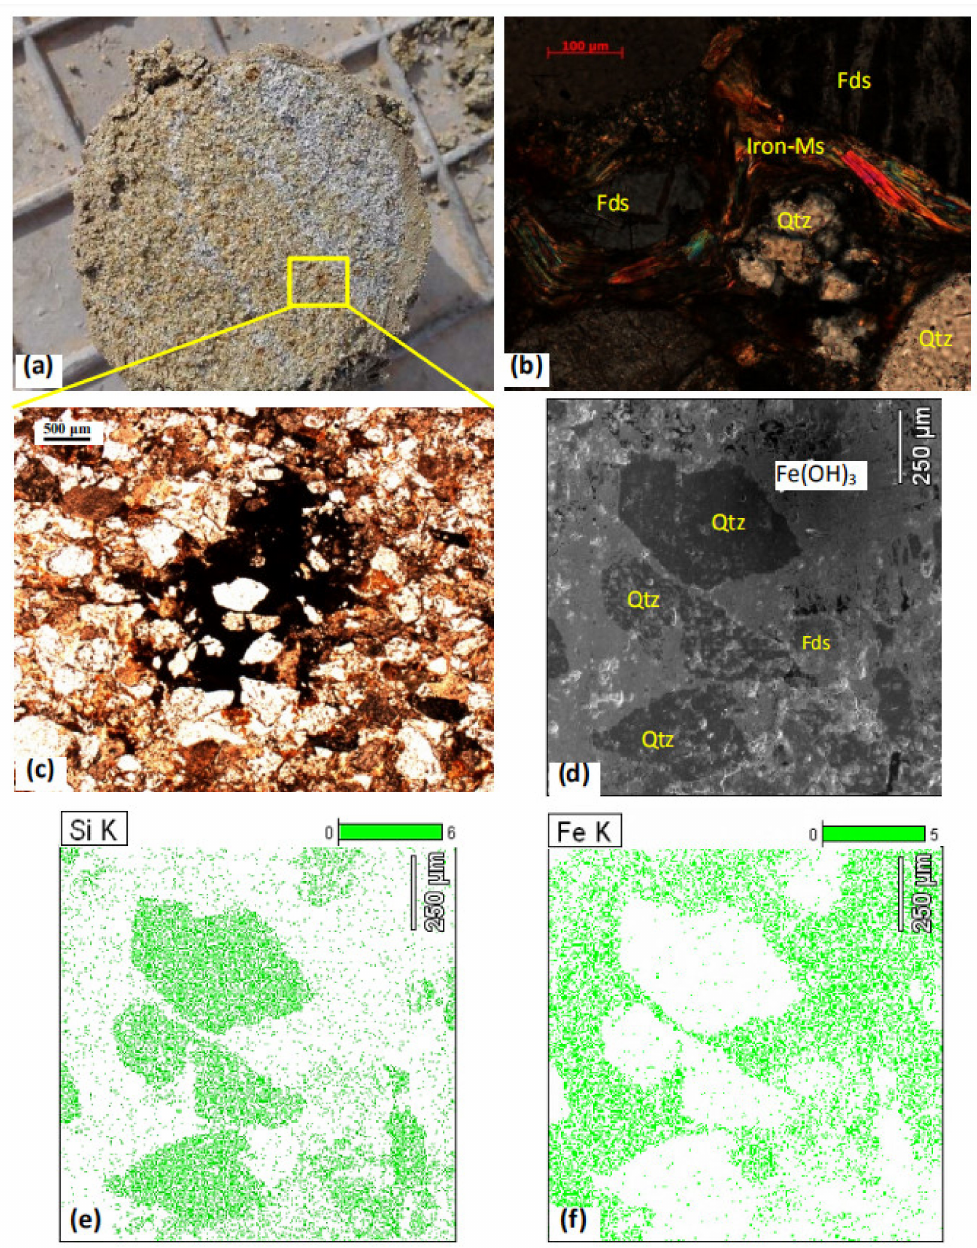
Figure 4. Macro- and micro-images for studied sandstone: ( a ) macro-observation showing the distinct yellow plugged area in sandstone (from [19]); ( b ) reddish-yellow sheet-like muscovite in pores (cross-polarized transmitted light); ( c ) opaque materials surrounding quartz grains (polarized transmitted light); ( d ) SEM enlarged image for central area in ( c ); and ( e ) and ( f ) are elemental mapping spectra for Si and Fe, respectively. Abbreviations are the same as in Figure